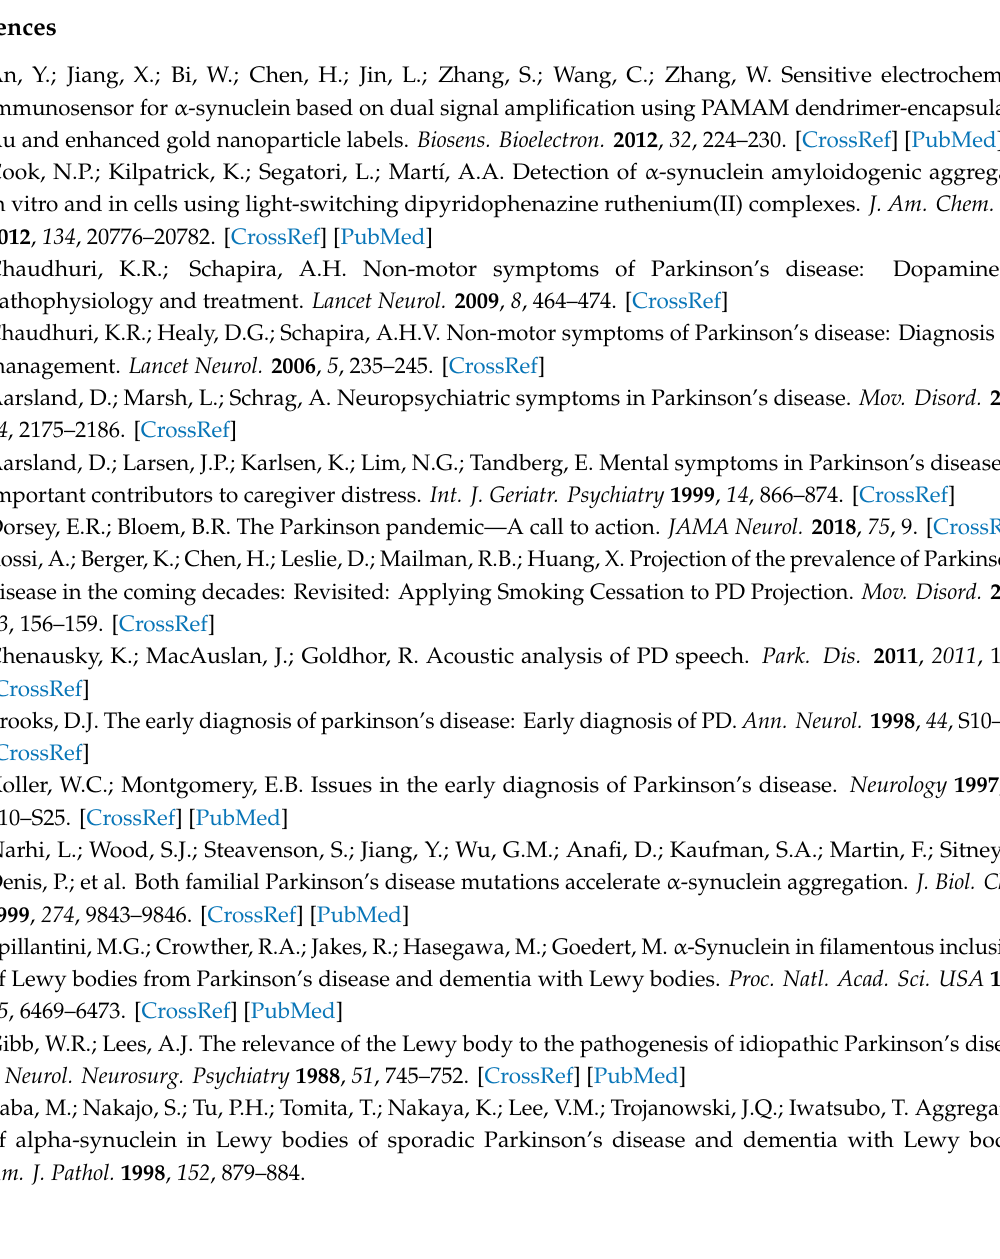
5 mM [Fe(CN) 6 ] 3 − . D. SEM image of bare GCE. Figure S2: A. Raman spectra of GO and ERGO. B. FT-IR spectra of GO and ERGO. Figure S3: A. Nyquist plots for the Apt / ERGO-GCE in di ff erent concentrations of α -syn oligomer (0 M, 1 fM, 1 pM, and 1 nM) in 0.1 M TBS bu ff er containing 5.0 mM [Fe(CN) 6 ] 3 − . B. Plausible sensing mechanism of Apt / ERGO-GCE for detection of α -syn oligomer. Figure S4: CV curves of Apt / ERGO-GCE at a scan rate of 50 mV s − 1 upon the addition of di ff erent concentrations of α -Syn oligomer (0–1 nM) in 0.1 M TBS bu ff